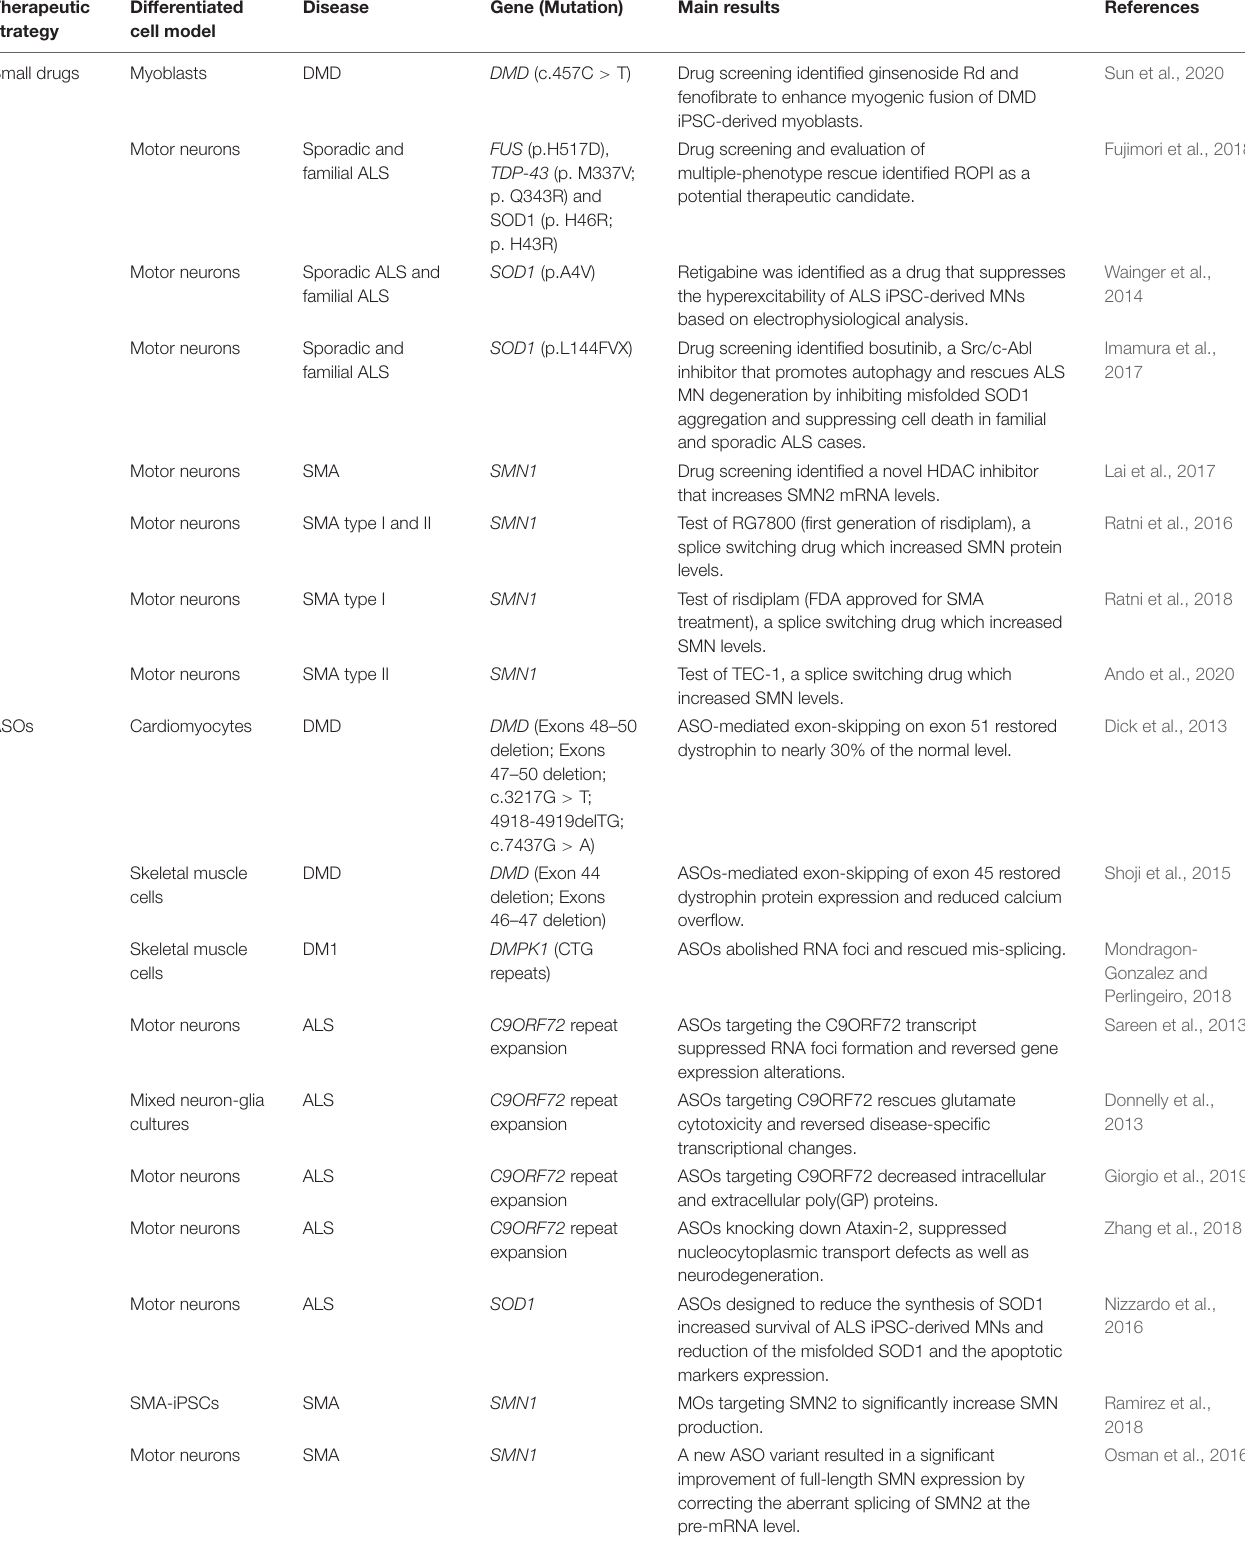
TABLE 1 | Summary of the major findings of the cited articles in which iPSCs were used for therapeutic tests of neuromuscular and motor neuron